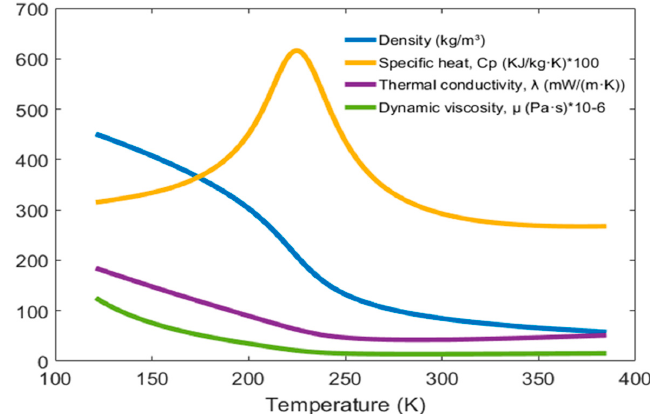
Figure 3. Thermo-physical properties of supercritical LNG at 10 MPa.